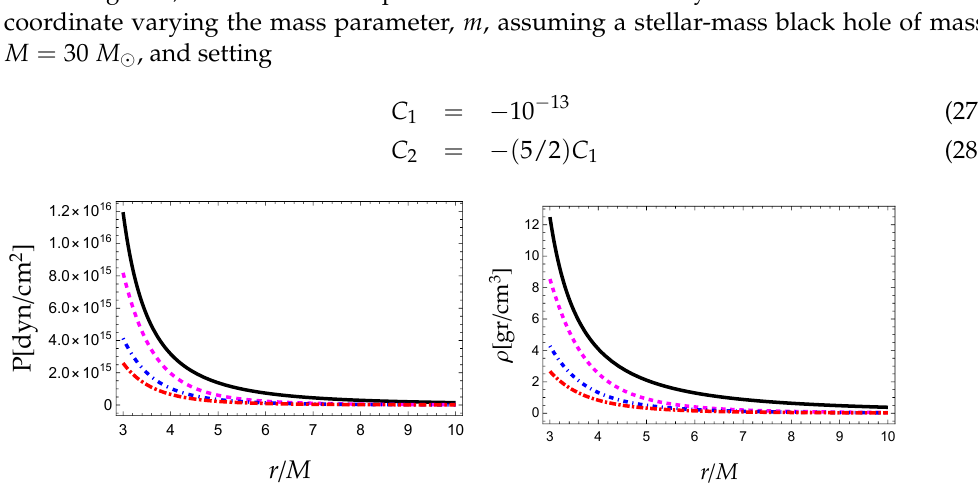
Figure 2. Pressure ( left ) and energy density ( right ) versus radial coordinate assuming M = 30 M (cid:12) . The color code is given as follows: m = 0 (solid black line), m = 40 × 10 − 22 GeV (dashed magenta line), m = 50 × 10 − 22 GeV (short-dashed blue line), and m = 60 × 10 − 22 GeV (long-dashed red